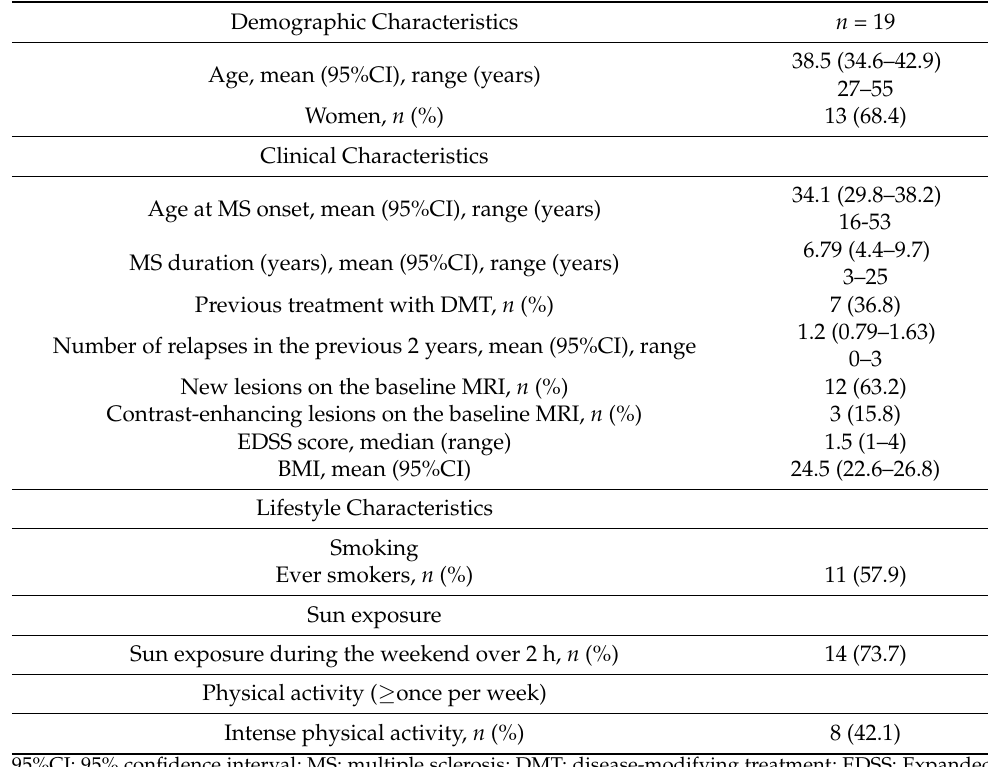
Table 1. Main demographic, clinical, and lifestyle characteristics of the study population at